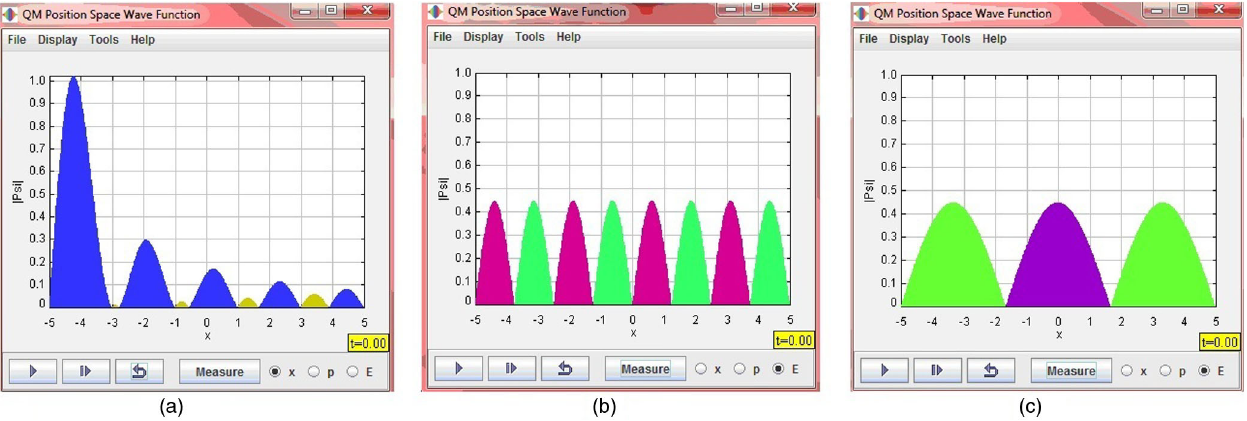
FIG. 3 (color online). Simulation program of the energy measurement on a superposition state [as shown in (a)] with nine energy eigenstate components. (b),(c) Examples of absolute values in position space of two basis energy eigenstates of the superposition